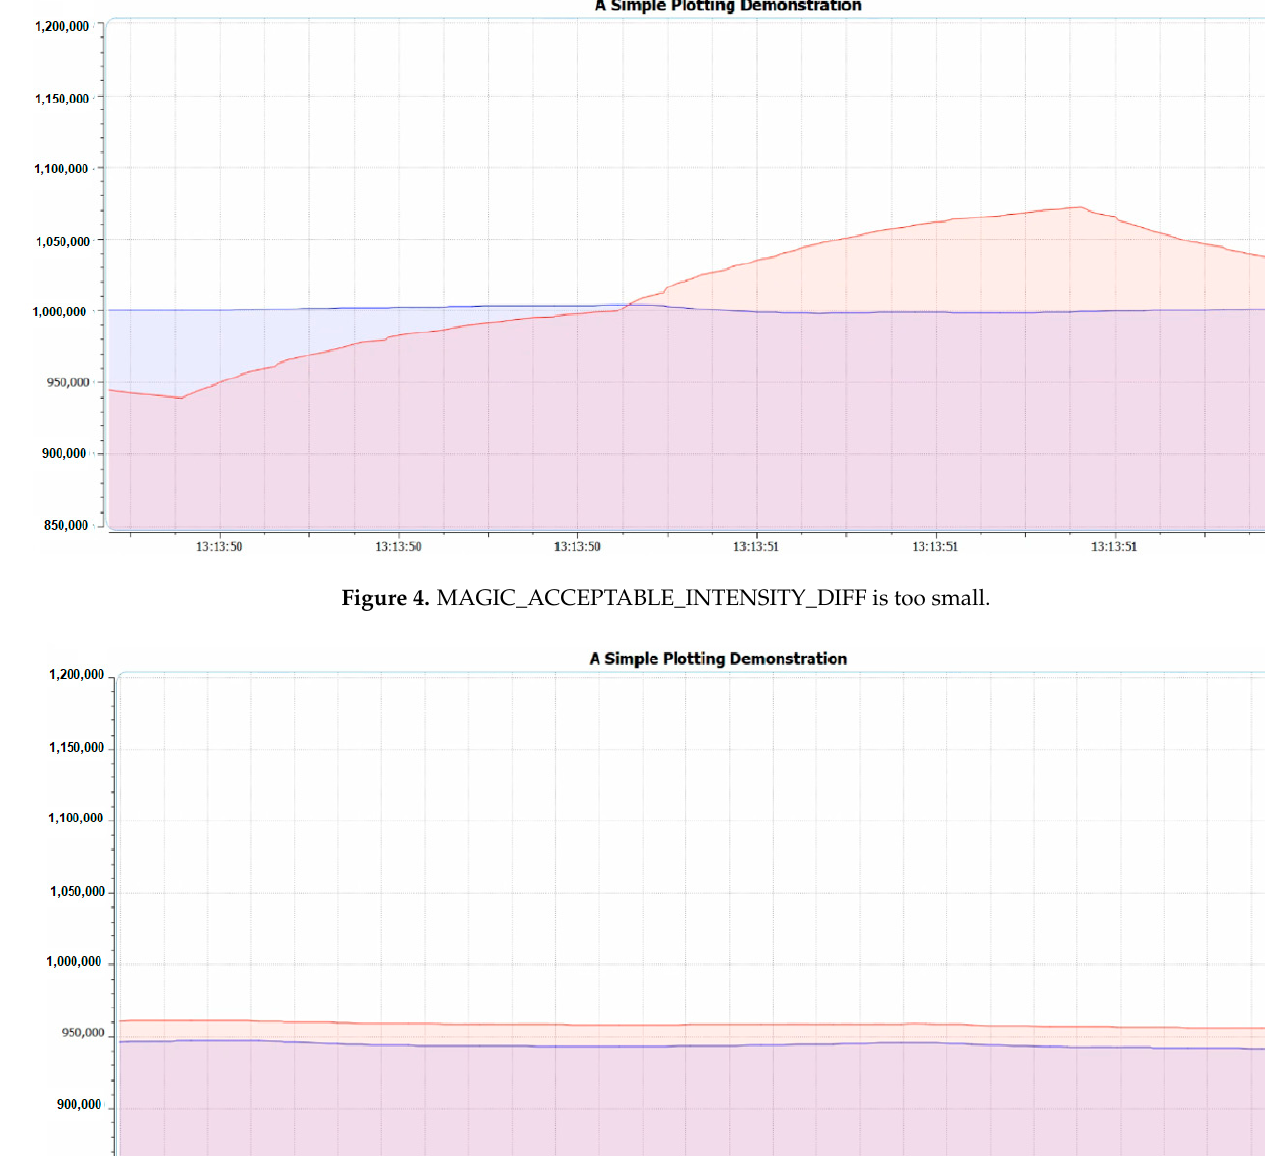
Figure 3. MAGIC_ACCEPTABLE_INTENSITY_DIFF (MAID) is too large.